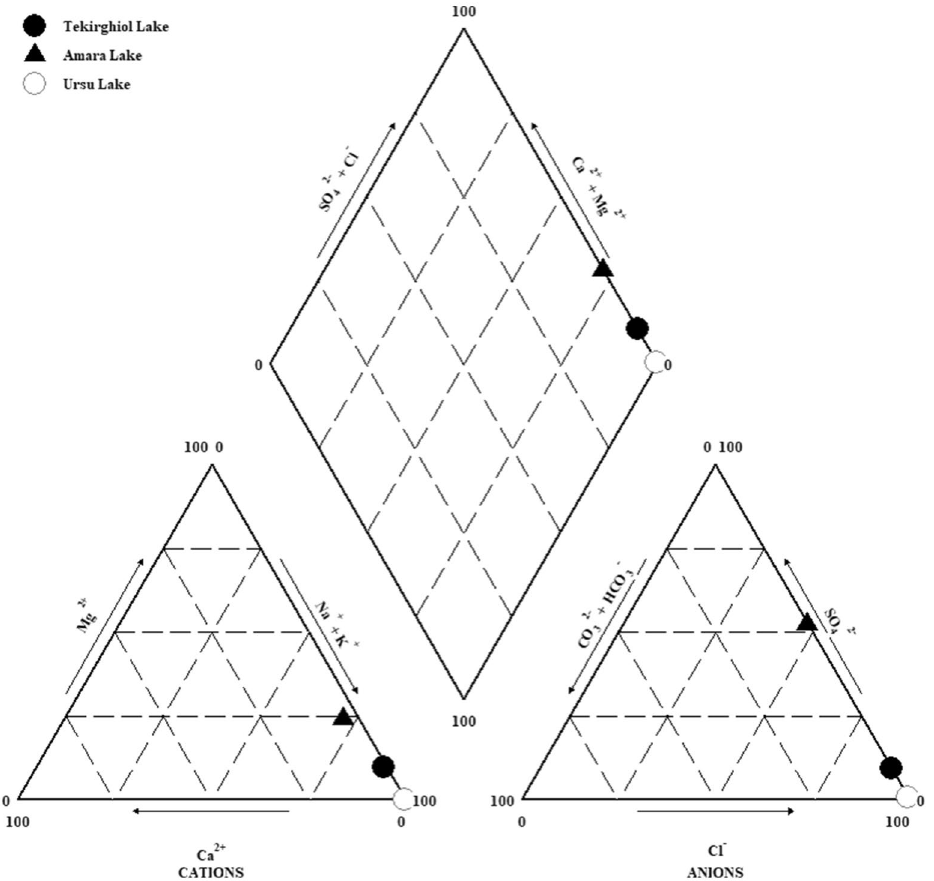
Figure 7. Piper diagram-based hydrochemical classification of Tekirghiol (full circle), Amara (full triangle) and Ursu (open circle) lakes